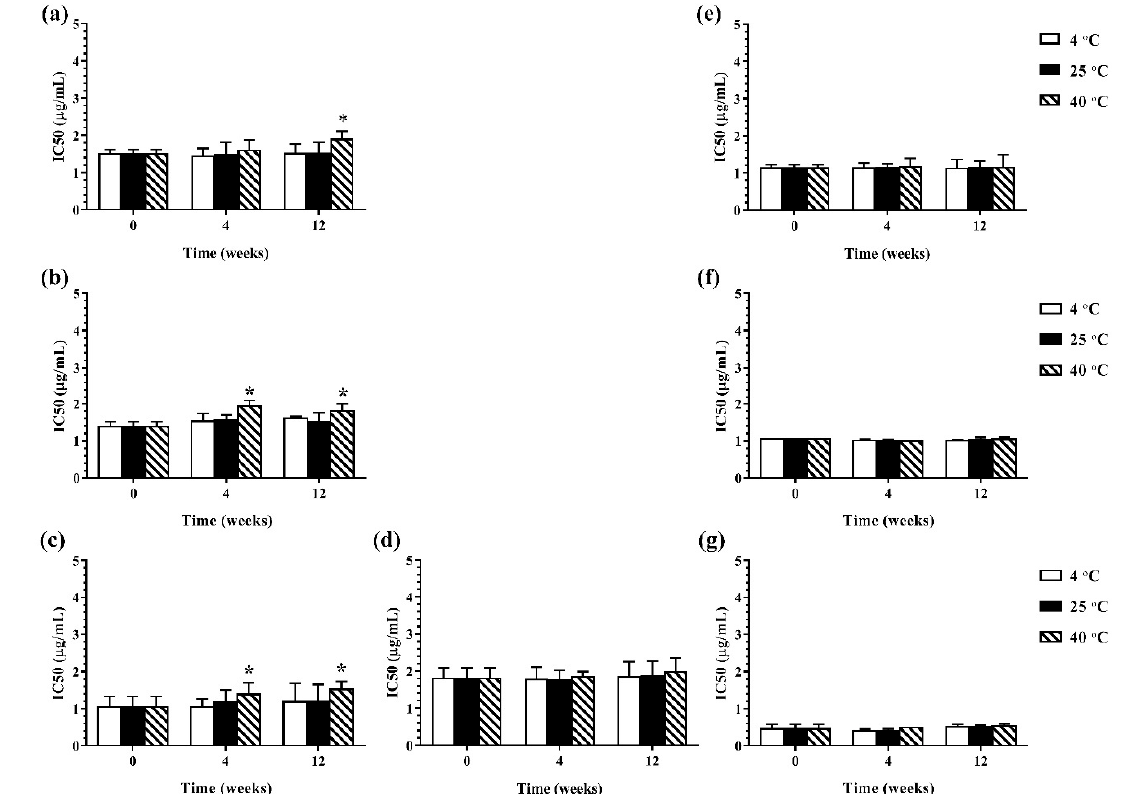
Figure 5. The IC 50 values of ME formulations kept at different storage temperatures (4 °C, 25 °C, and 40 °C); ME-AGO-3 against A. flavus ( a ), A. niger ( b ), and F. solani ( c ), ME-C-3 against F. solani ( d ) and ME-M-3 against A. flavus ( e ), A. niger ( f ), and F. solani ( g ). Asterisk (*) indicates significant differences between groups ( p < 0.05).